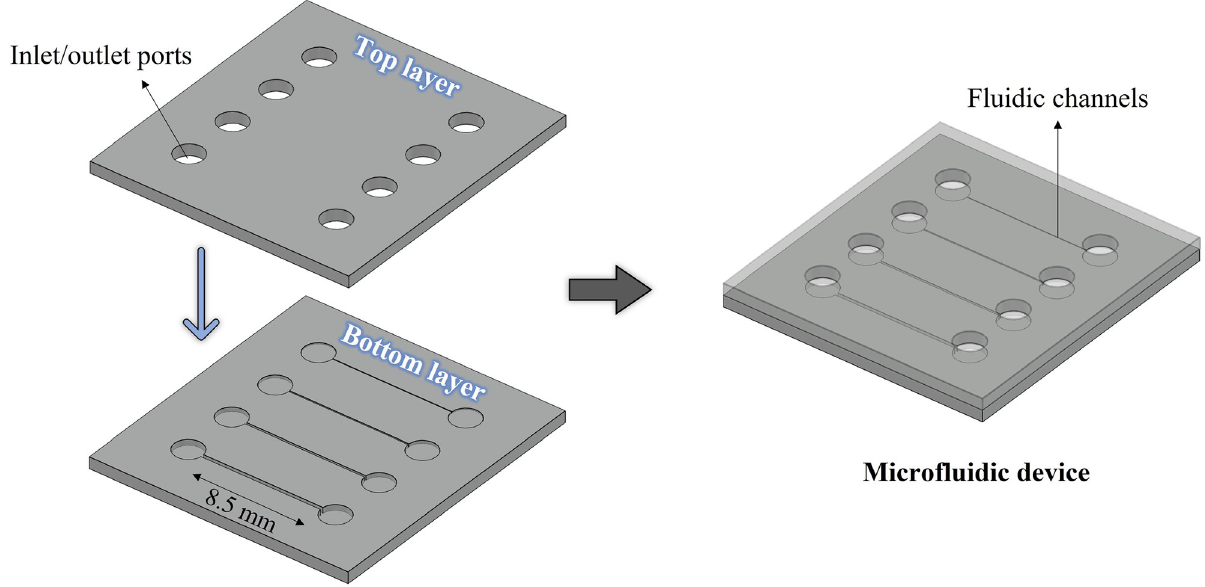
Fig 5. Design of the microfluidic devices. Schematic illustration of the design of the microfluidic devices used for the model validation (right side). The bottom and top layers the microdevice is made of are shown on the left side.